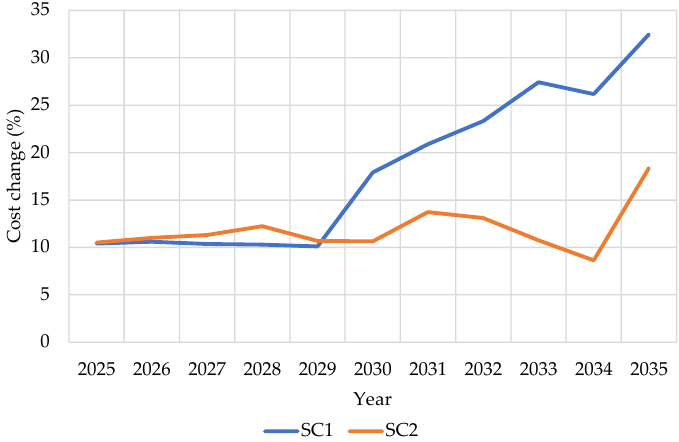
Figure 2. Unserved energy (%) in the case of the loss of all electricity import sources. This indicator is demonstrated only during the time period of disruption. Higher im- pact of the disruption and lower energy system resilience are seen in SC1, which is more dependent on electricity imports in comparison with SC2. In SC1, 23% of electricity im- ports is needed for the energy system to avoid unserved energy in 2025, whereas the value in SC2 is 8% at the same time. However, the indicators in both scenarios decrease with the decreasing dependency on electricity import. The energy system can survive without elec- tricity imports from 2029 in SC2 and from 2034 in SC1. In 2025, the share of electricity imports in the electricity supply still covers the largest proportion in both scenarios without disruptions, 62.5% in SC1 and 47.5% in SC2. This is estimated by the import dependency indicator, presented in Figure 3. Obviously, the val- ues of this indicator should not be taken into account during disruption scenarios (SC1_D1 and SC2_D1) when all electricity import sources are lost and indicators are equal to 0. Figure 3. Import dependence (%) in the case of the loss of all electricity import sources. Change in energy system total costs was also evaluated during the disruption time frame (Figure 4). Over time, the indicators increase since relatively cheaper electricity imports are replaced due to unavailability with technologies that produce electricity at higher costs.